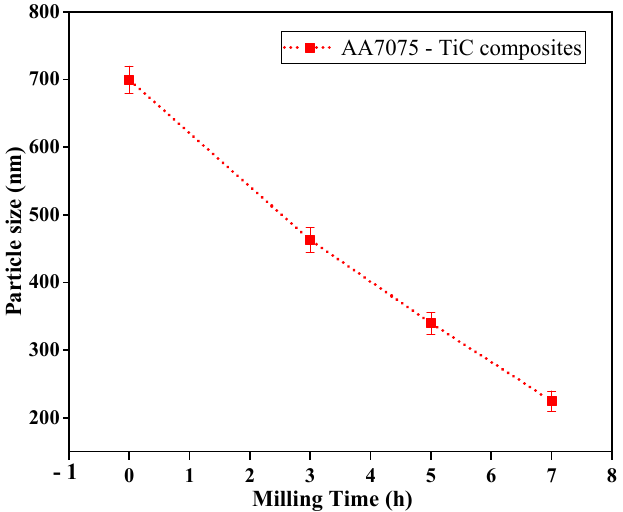
Figure 9. Effect of milling time on the size of particles determined by particle size analysis.